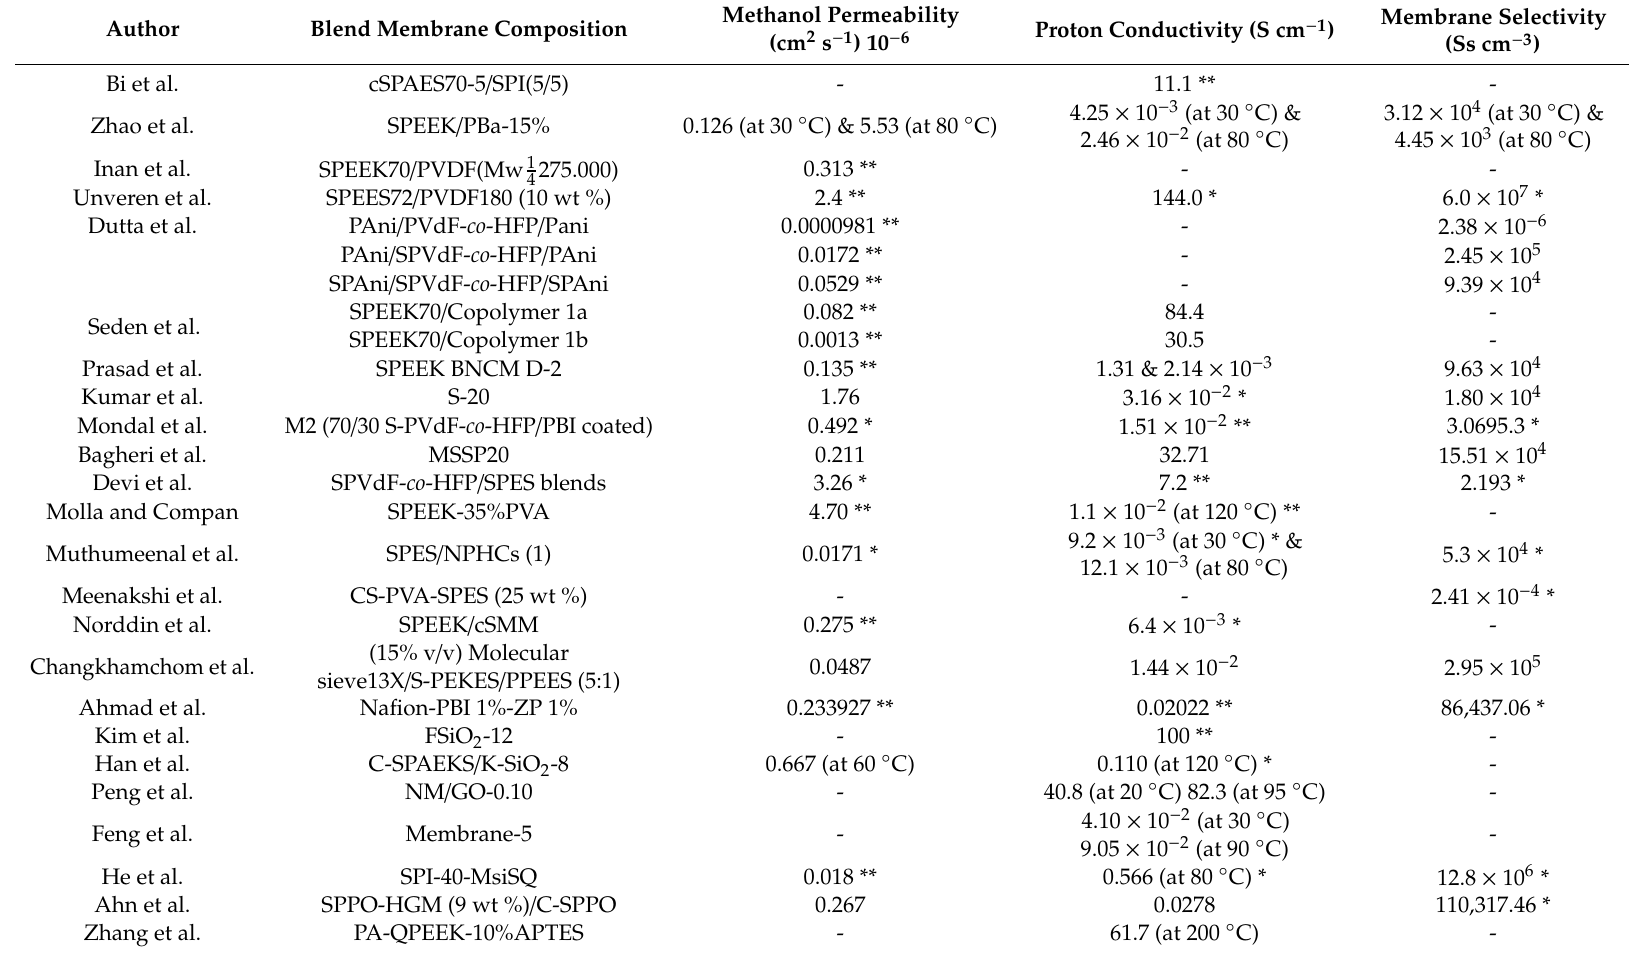
Table1. Dataonmethanolpermeability, protonconductivity, andselectivityofs-Polycomposite / organic–inorganichybridmembranescomparedtoNafion ®